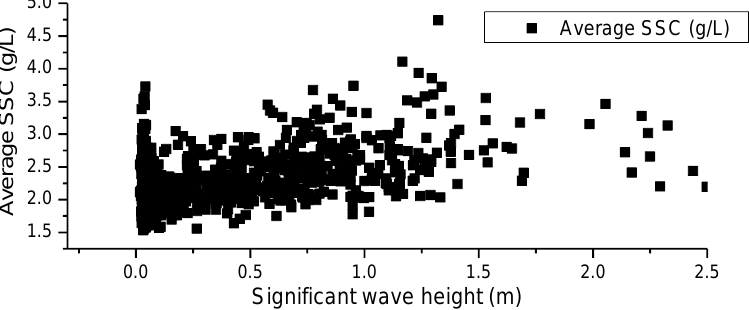
Figure 11. The average SSC under significant wave height below 1.25 m condition is not lower than the SSC when the significant wave height exceeds 1.5 m.